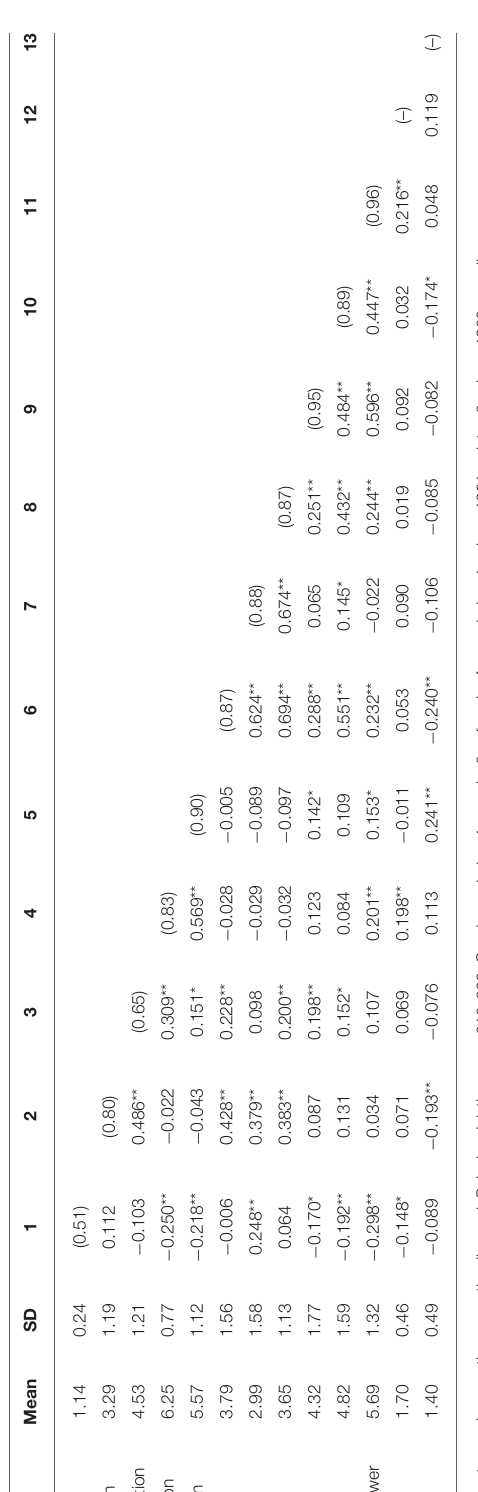
are shown in Table 6